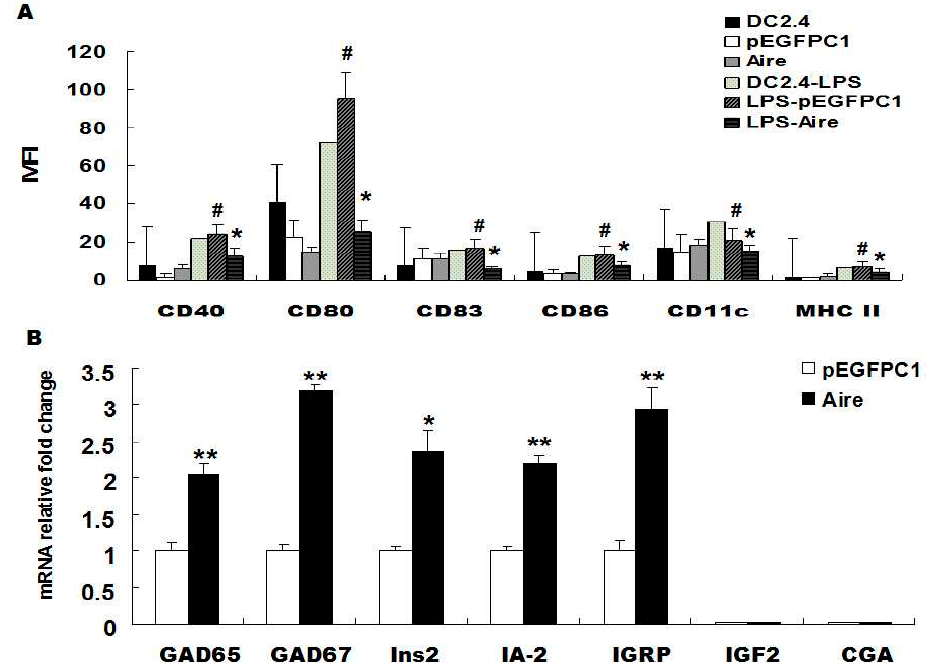
Figure 1. Aire affected the maturation of DC2.4 and its TRA expression levels. ( A ) The expression of CD40, CD80, CD83, CD86, CD11c and MHC II were detected by FACS in Aire and control cells with or without stimulation with 10 μ g/mL of LPS for 48 h; ( B ) GAD65/67, Ins2, IA-2, IGRP, IGF2, and CGA levels were detected by RT-qPCR in Aire and control cells. The data are shown as the expression levels relative to the expression of GAPDH and are depicted as the fold changes relative to the control cells normalized to 1. The data are expressed as the means±SD from three to five independent experiments. # p < 0.05, LPS stimulation vs. control; * p < 0.05, Aire vs. pEGFPC1, ** p < 0.01,Aire vs . pEGFPC1.